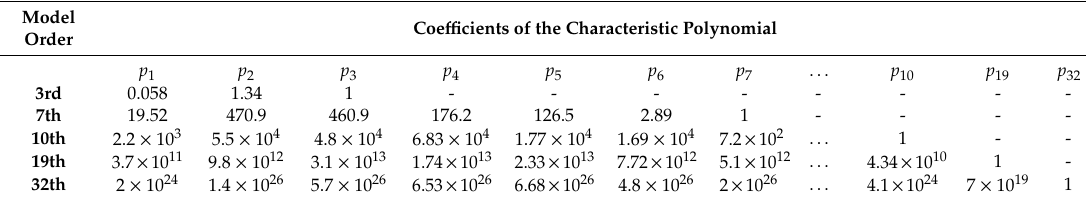
Table 2. Characteristic polynomial coe ffi cients with di ff erent order LTI models. Plant 4. Model